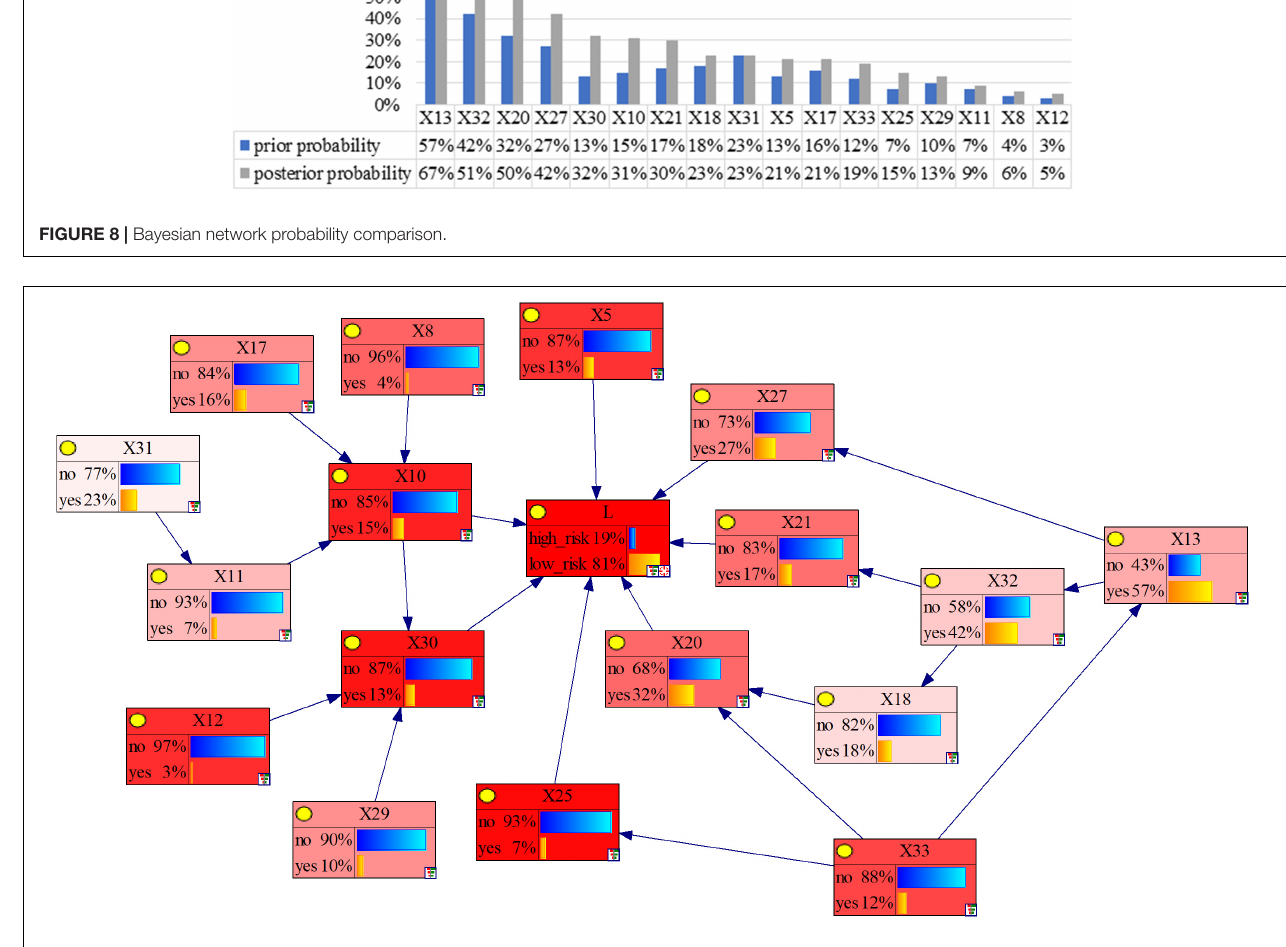
FIGURE 9 | Bayesian network sensitivity